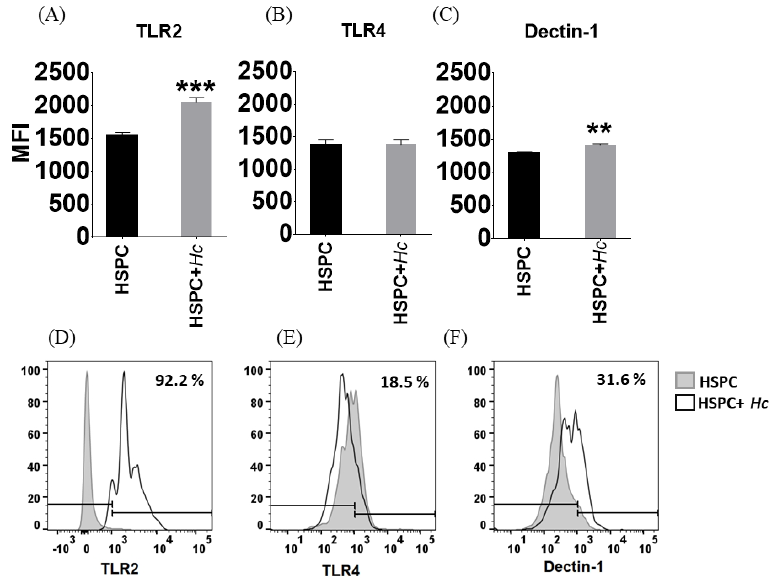
Figure 2. Expression of TLR2, TLR4 and Dectin-1 receptors in HSPC. ( A , D ) TLR2 expression in unstimulated and stimulated HSPC with H. capsulatum yeasts; ( B , E ) TLR4 expression in unstimulated and stimulated HSPC with H. capsulatum yeasts; ( C , F ) Expression of Dectin-1 in unstimulated and stimulated HSPC with H. capsulatum yeasts. HSPCs were selected from the CD105 + /Sca ‐ 1 + population and the level of expression of receptors is expressed as mean fluorescence intensity (MFI). ( A – D ) Results are expressed as means ± SD of pooled data from three independent experiments. ( D – F ) Data represent the percentage of HSPC positive cells and are from a representative experiment of three replicates, ** p < 0.01; *** p < 0.0001. 3.3. HSPCs Are Able to Phagocytose H. capsulatum Yeasts but Do Not Exert a Fungicidal Effect It was observed that HSPCs have the capacity to adhere to and internalize the yeasts of H. capsulatum . These cells showed a percentage of phagocytosis of 17.7% (Figure 3A). Results are shown as a percentage of FITC positive cells. Treatment of HSPC with anti ‐ bodies specific for TLR2 and TLR4, and the peptide CLEC7A specific for Dectin ‐ 1, indi ‐ vidually or in combination, was shown to result in a significant decrease in the percentage of phagocytosis in all cases ( p < 0.0001) (Figure 3B–H). The results suggest that this process is dependent on TLR2, TLR4, and Dectin ‐ 1. On the other hand, when evaluating the mi ‐ crobicidal effect of HSPC against the yeasts of H. capsulatum, it was observed that the growth of the fungus was not affected (Figure 4).